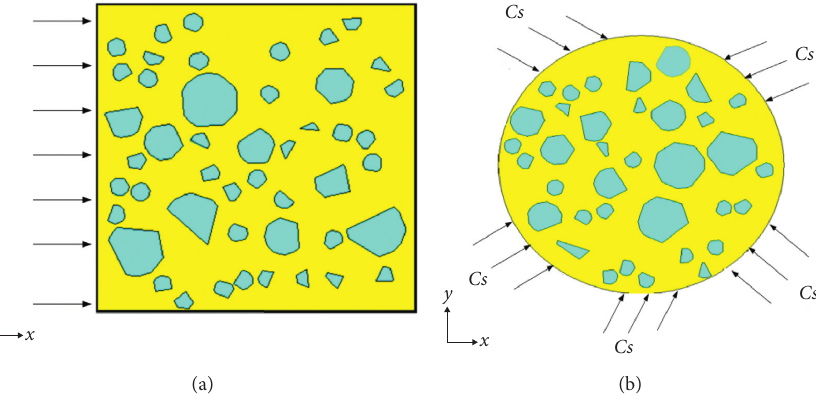
Figure 1: The mesoscale model of concrete.